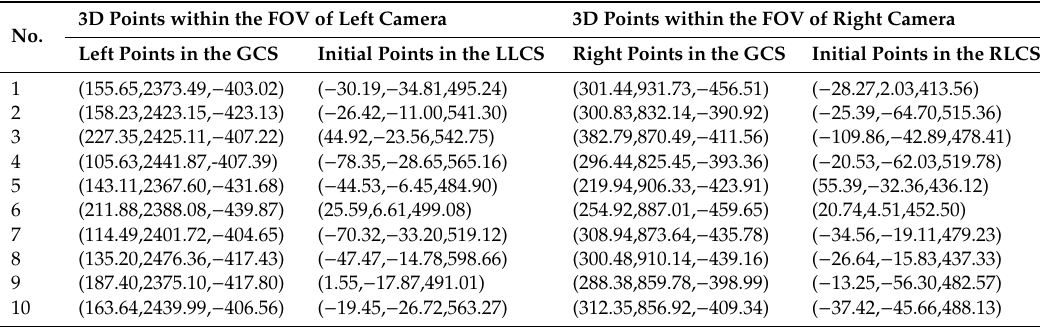
Table 2. 3D coordinates of the target sphere center in the GCS and LCS (mm).